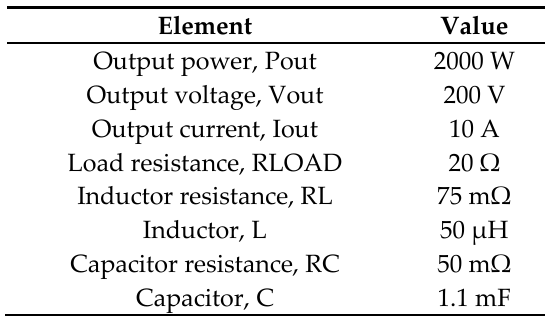
Table 1. Boost converter nominal